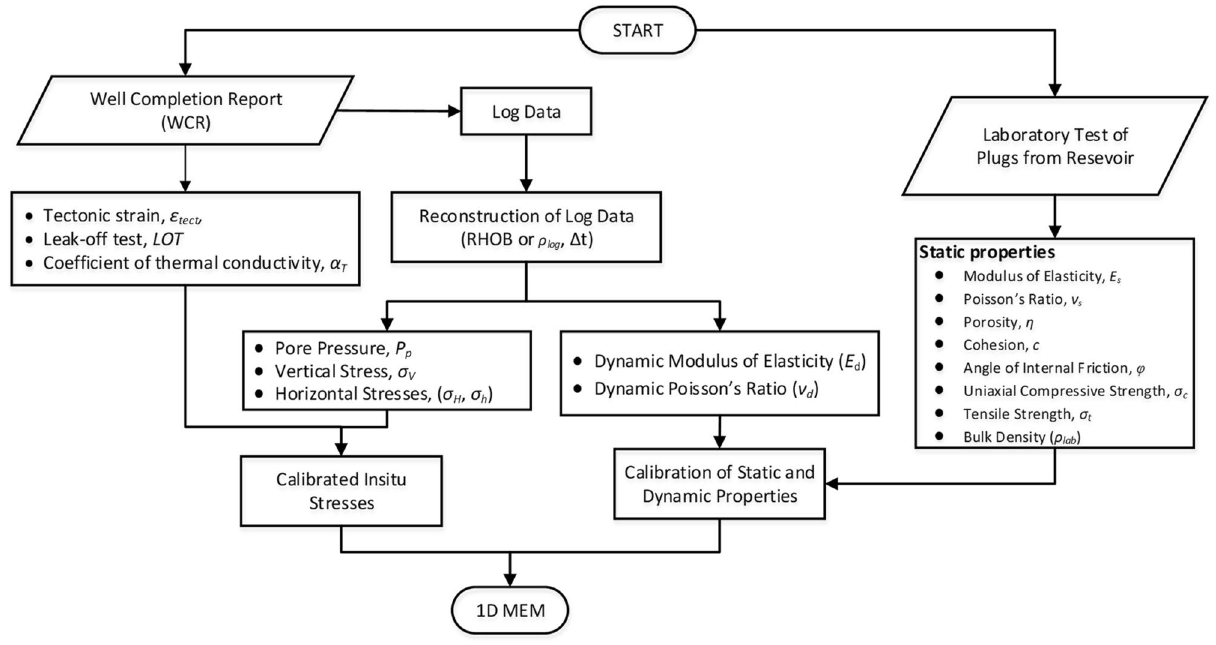
Figure 4. Flow chart for 1D MEM